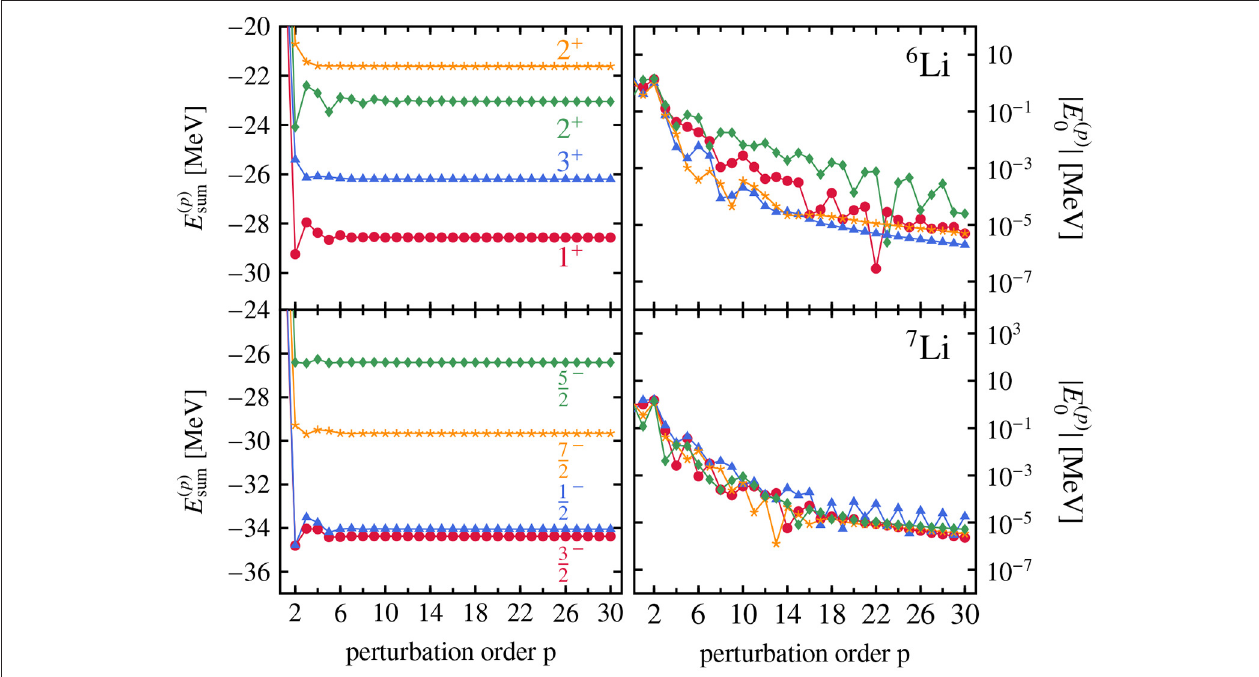
FIGURE 6 | High-order binding energies from NCSM-PT employing N ref max = 0 reference states using the Hamiltonian described in section 3. All calculations are performed including configurations up to N max = 8 and employ an oscillator frequency of ¯ h ω = 20MeV. The SRG parameter is set to α = 0.08fm 4 . Reproduced from Tichai et al. [36] under the Creative Commons CC-BY license.